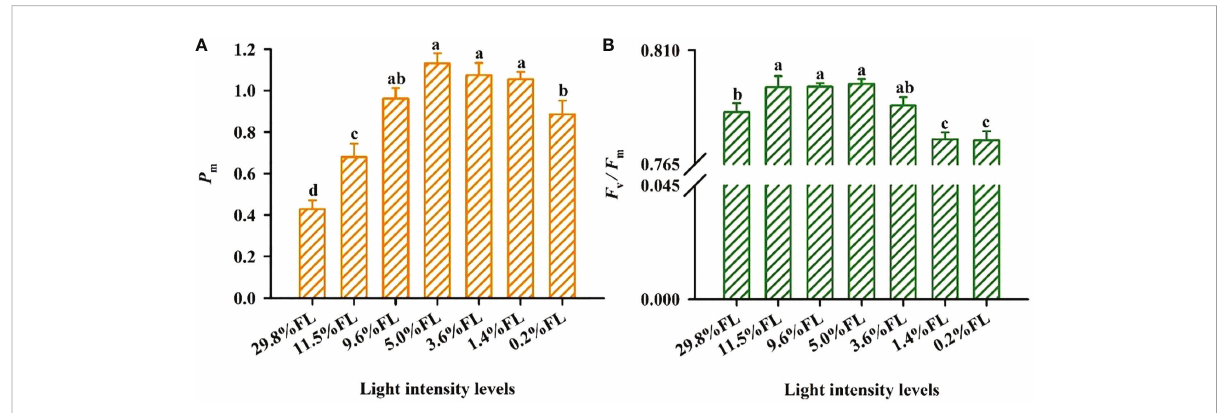
FIGURE 3 The effect of light regimes on PSI and PSII activity of Panax notoginseng. (A) P m is the maximum photo-oxidation P + 700 . (B) F v / F m is the maximum ef fi ciency of PSII photochemistry. Values for each point were means ± SD ( n = 7). Letters indicate signi fi cant differences at P < 0.05 according to Duncan ’ s multiple range